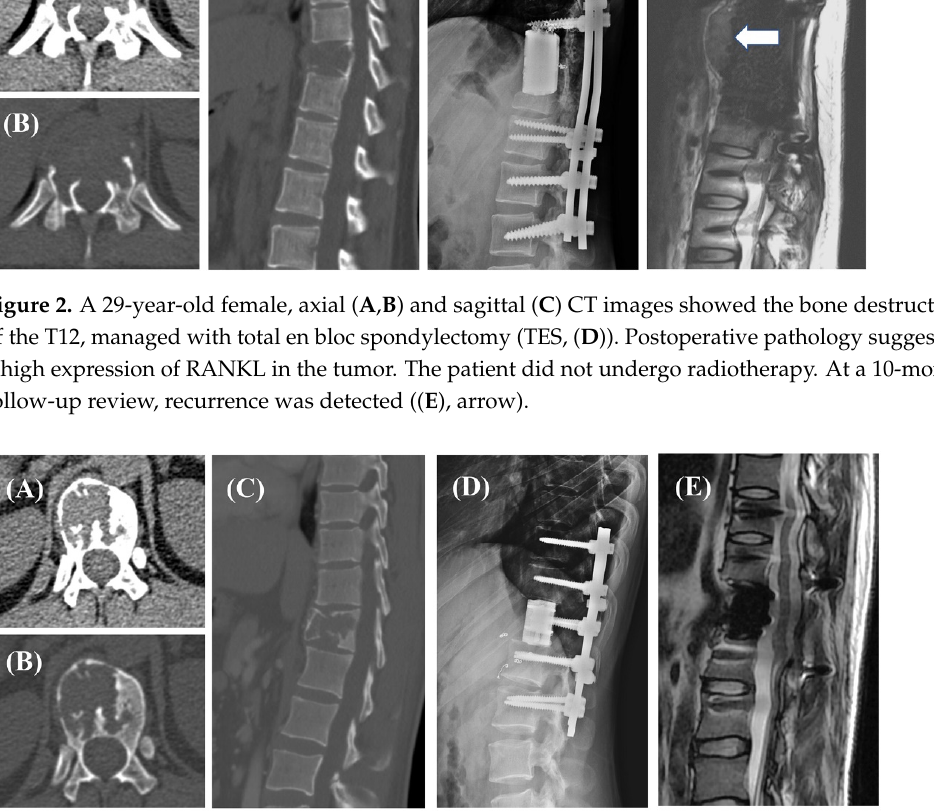
Figure 3. A 32-year-old male, CT images ( A – C ) showed a pathologic fracture of the T12 vertebra, man- aged with TES ( D ). Postoperative pathology showed low expression of RANKL without radiotherapy. At the 32-month follow-up, there was no evidence of recurrence ( E